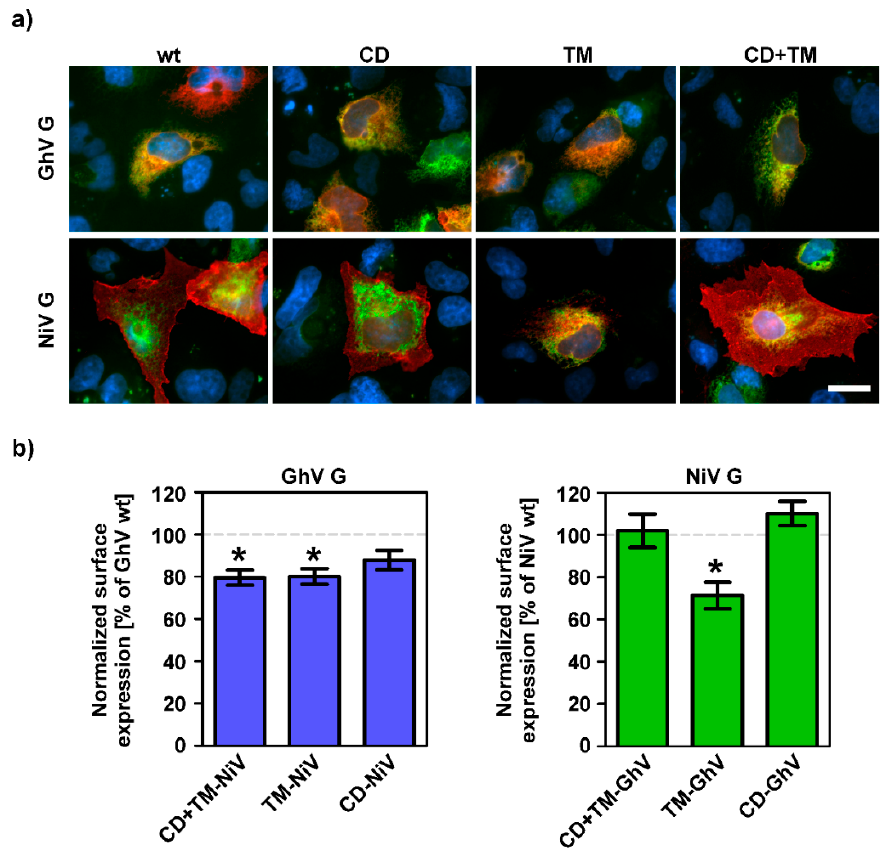
Figure 5. Replacement of GhV CD and TM does not increase the surface expression level of chimeric G proteins. ( a ) Fruit bat (HypNi / 1.1) cells were transfected for the coexpression of wildtype or chimeric G proteins and a cellular compartment marker for the endoplasmic reticulum (ER). Red: G proteins, green: ER, blue: nuclei. Scale bar indicates 20 µ m. ( b ) Surface expression of chimeric G proteins was quantified by flow cytometry. The mean fluorescence intensity obtained for chimeric G proteins was further normalized to that of the corresponding wildtype G proteins, which were set as 100%. The graph shows mean and SEM of three independent trials. Statistical significance of di ff erences in surface expression of mutant versus wildtype G proteins was tested by paired, two-tailed Student’s t -tests with 95% confidence intervals (*: p ≤ 0.05). Table 3. Syncytium formation following coexpression of GhV or NiV F and chimeric G proteins. Glycoprotein